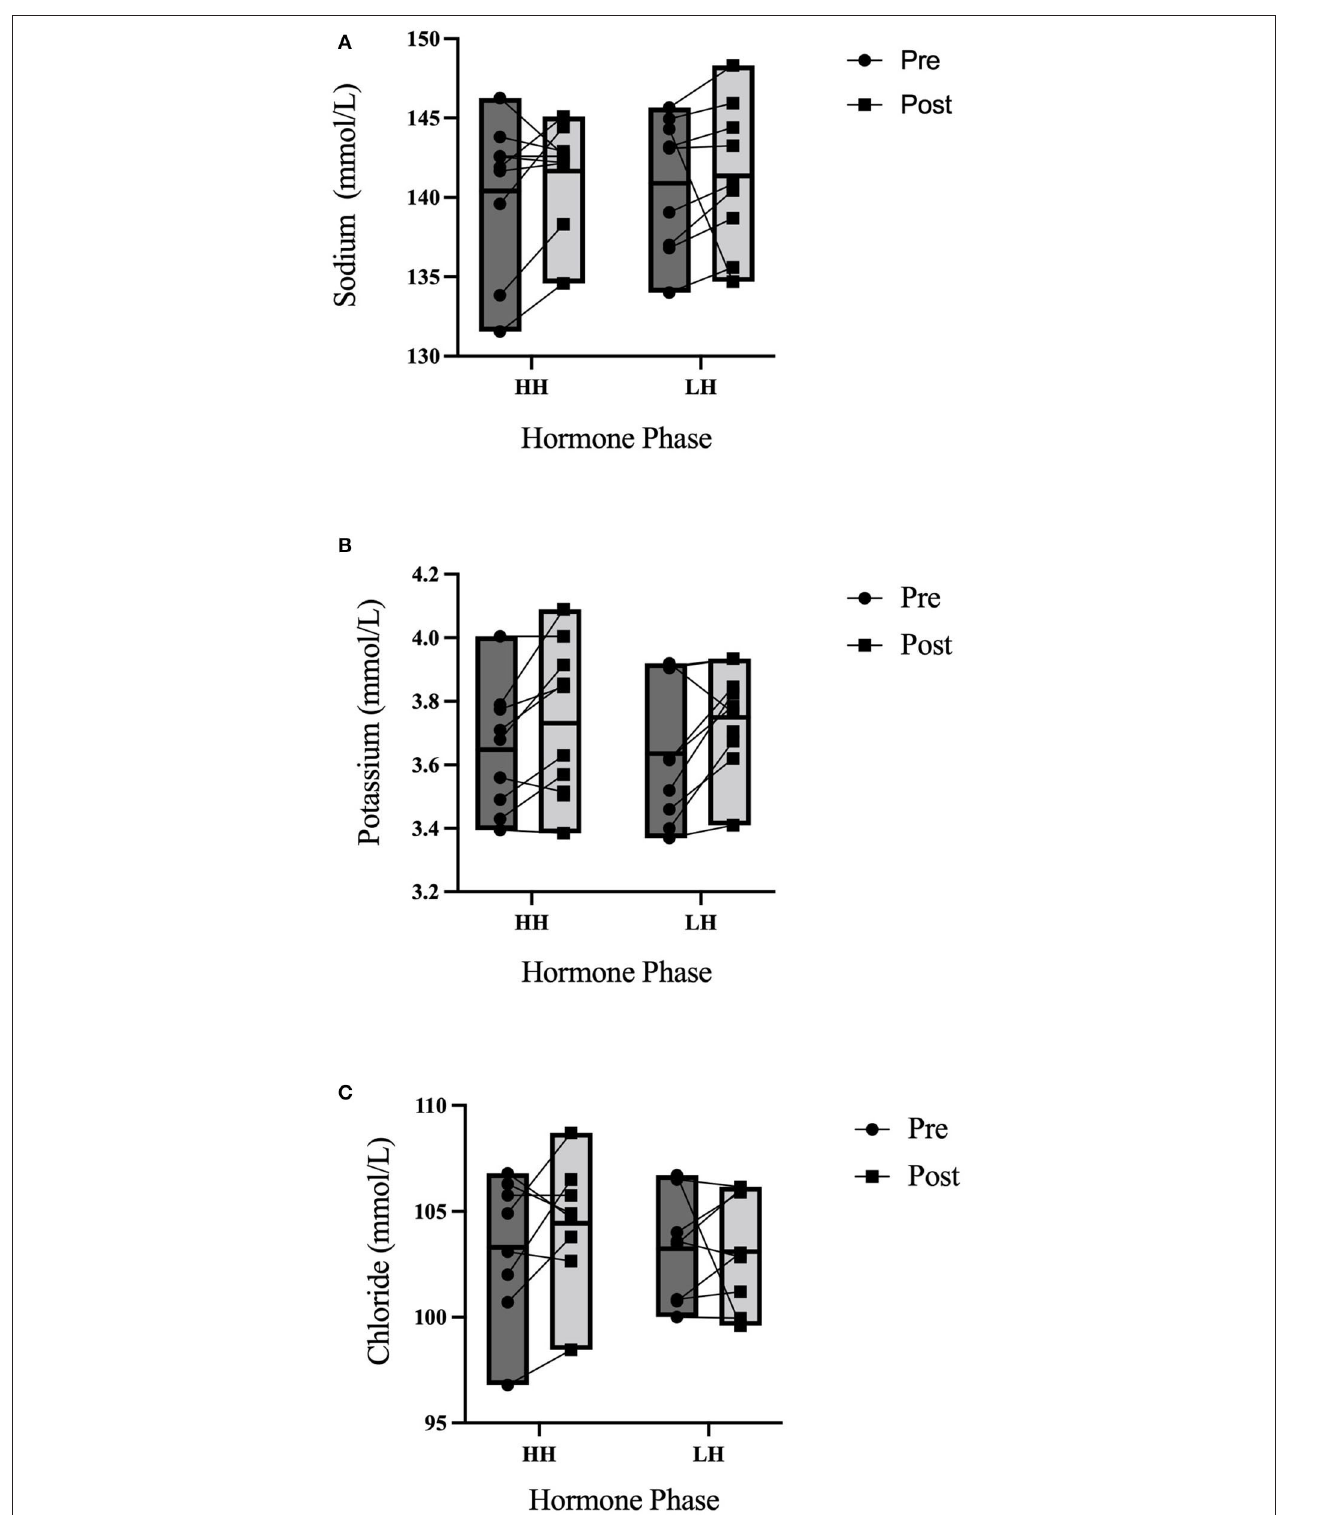
FIGURE 2 | 3-h electrolyte responses to an acute water bolus. Individual responses and group summary data is shown ( n = 9). Markers represented individual responses whereas bars represent group means and range. (A) Plasma Na + did not differ from pre- to post-trial ( P = 0.408) nor were concentration levels different between trials ( P = 0.275) nor was there an interaction effect ( P = 0.481). (B) There were no differences in Plasma K + over time ( P = 0.103) or between trials ( P = 0.852) nor was there an interaction effect ( P = 0.828). (C) There were no differences in Cl − over time ( P = 0.380), between trials ( P = 0.428) nor was there an interaction effect ( P =